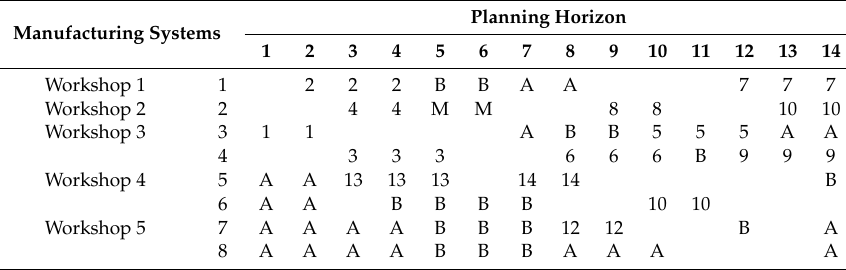
Table 6. Optimal manufacturing